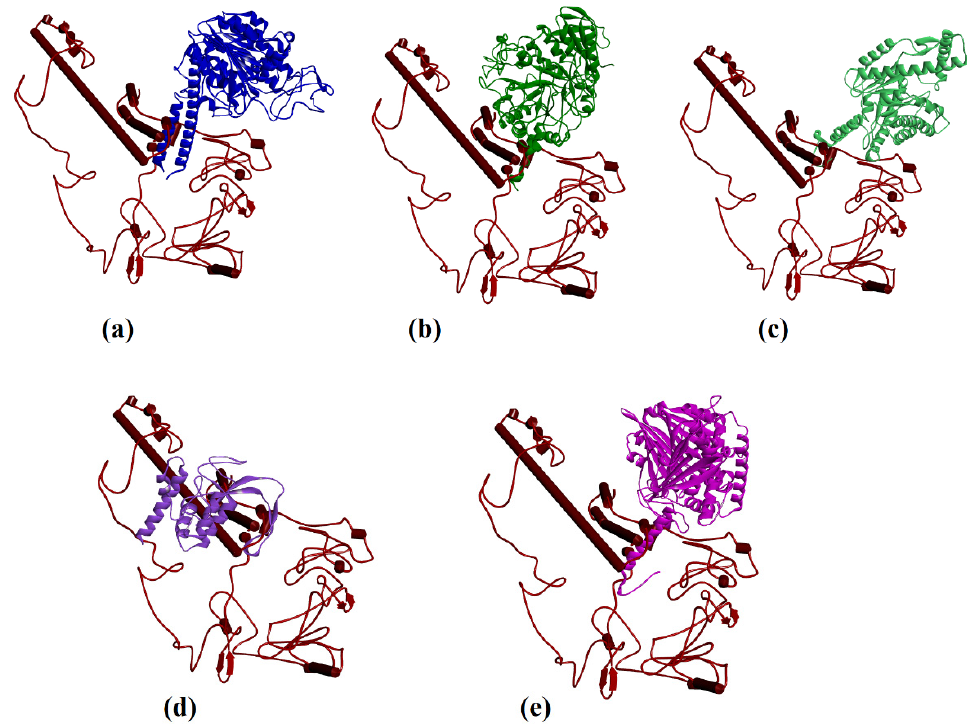
Figure 4. ( a ) Interaction of honeybee venom protein alkaline phosphatase with normal Ebola viral spike protein. ( b ) Interaction of honeybee venom protein glucosidase with normal Ebola viral spike protein. ( c ) Interaction of honeybee venom protein hyaluronidase with normal Ebola viral spike protein. ( d ) Interaction of honeybee venom protein phospholipase A2 with normal Ebola viral spike protein. ( e ) Interaction of honeybee venom protein phospholipase B with normal Ebola viral spike